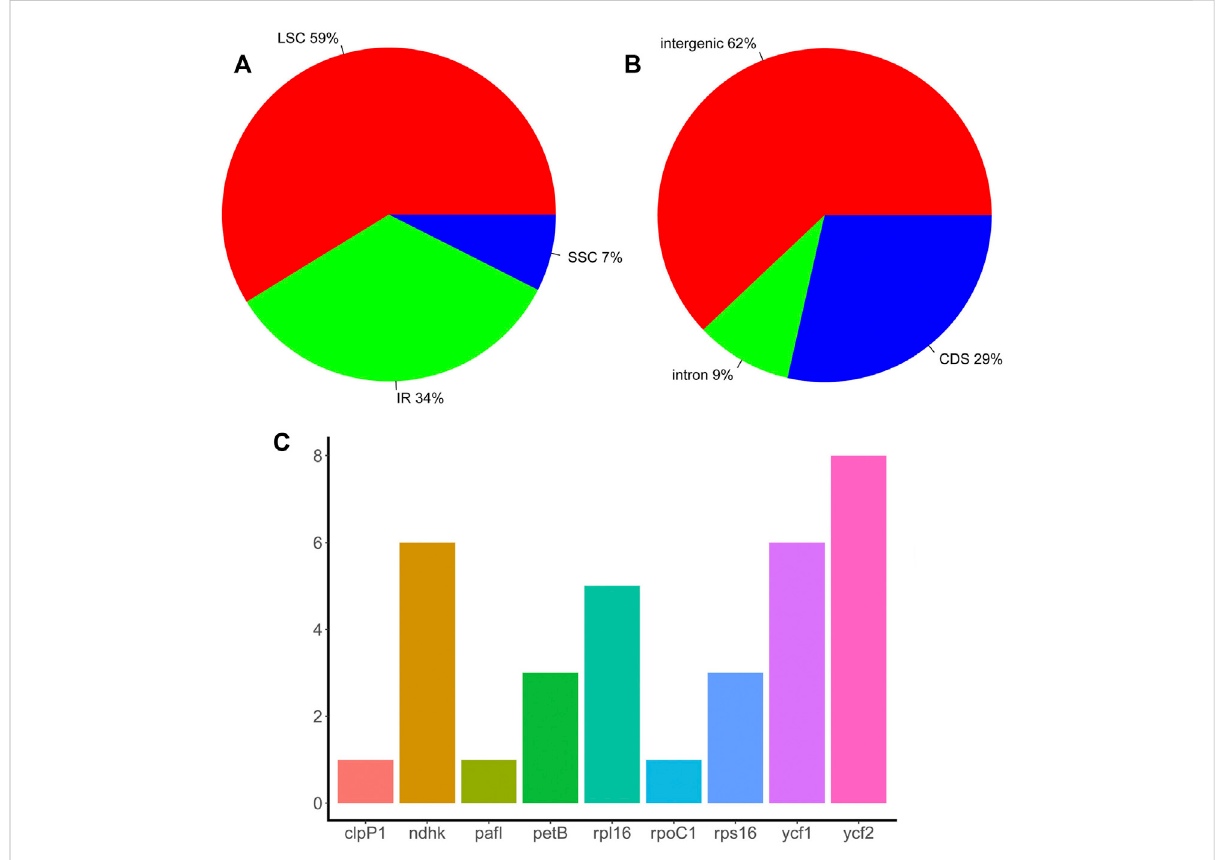
FIGURE 2 The distribution of repeat sequences in Piper chloroplast genomes. (A) The proportion of repeat sets in the three regions (IR, LSC, and SSC). (B) The proportion of repeat sets in introns, intergenic regions, and CDS. (C) The number of repeat sets in different